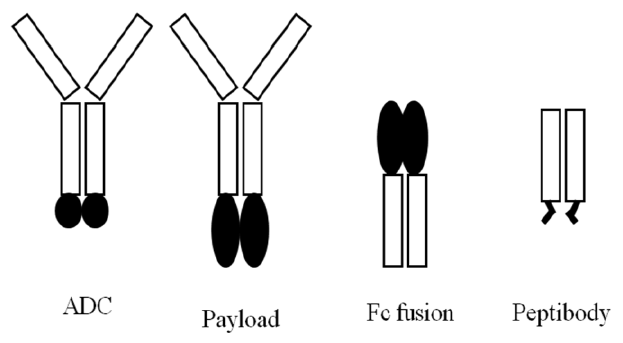
Figure 1. Illustrative comparison of the structure of ADC to those of fusion proteins. Note